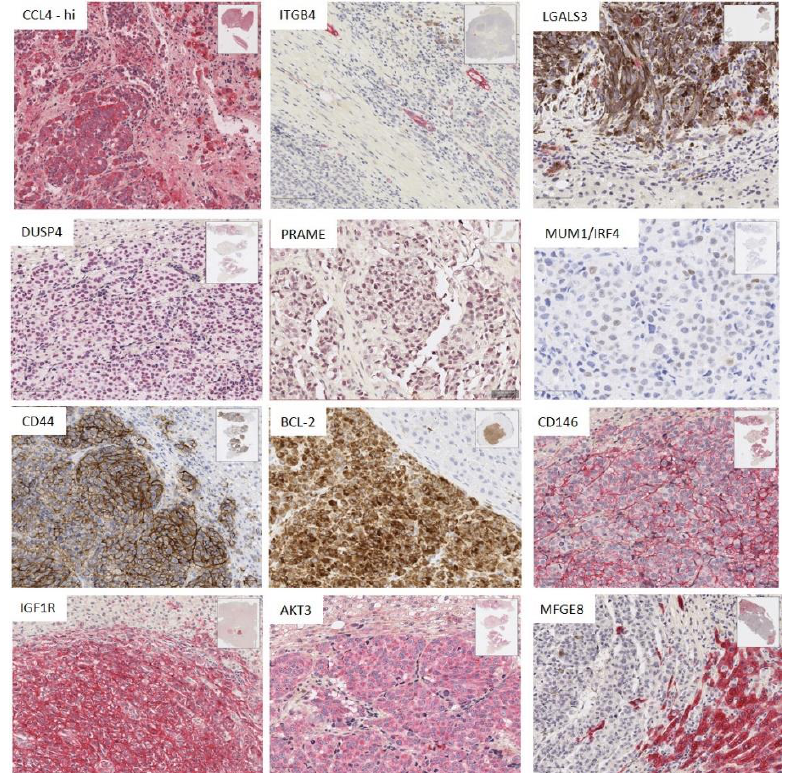
Figure 5. Immunohistochemistry (IHC) results showing the staining pattern and spatial distribution of positive cells for antibodies against the proteins encoded by genes of interest identified from NanoString analyses (scale bar: 100 µm for CCL4, ITGNB4, and DUSP4. All other IHC panels scale bar: 50 µm). (Table S4 summarizes the key findings).